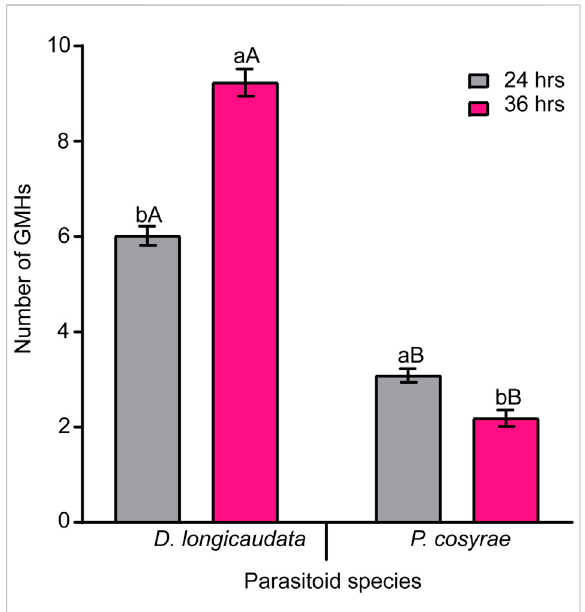
FIGURE 6 Parasitic wasp-induced formation of GMH in B. dorsalis . Bars capped with different letters (lowercase letters denote differences withintimepointsofthesameparasitizedgroupswhileuppercase letters denote differences between the different parasitoids analyzed at the same time point) are statistically different (Tukey tests: p ≤ 0.05, n = 60). Error bars indicate ±